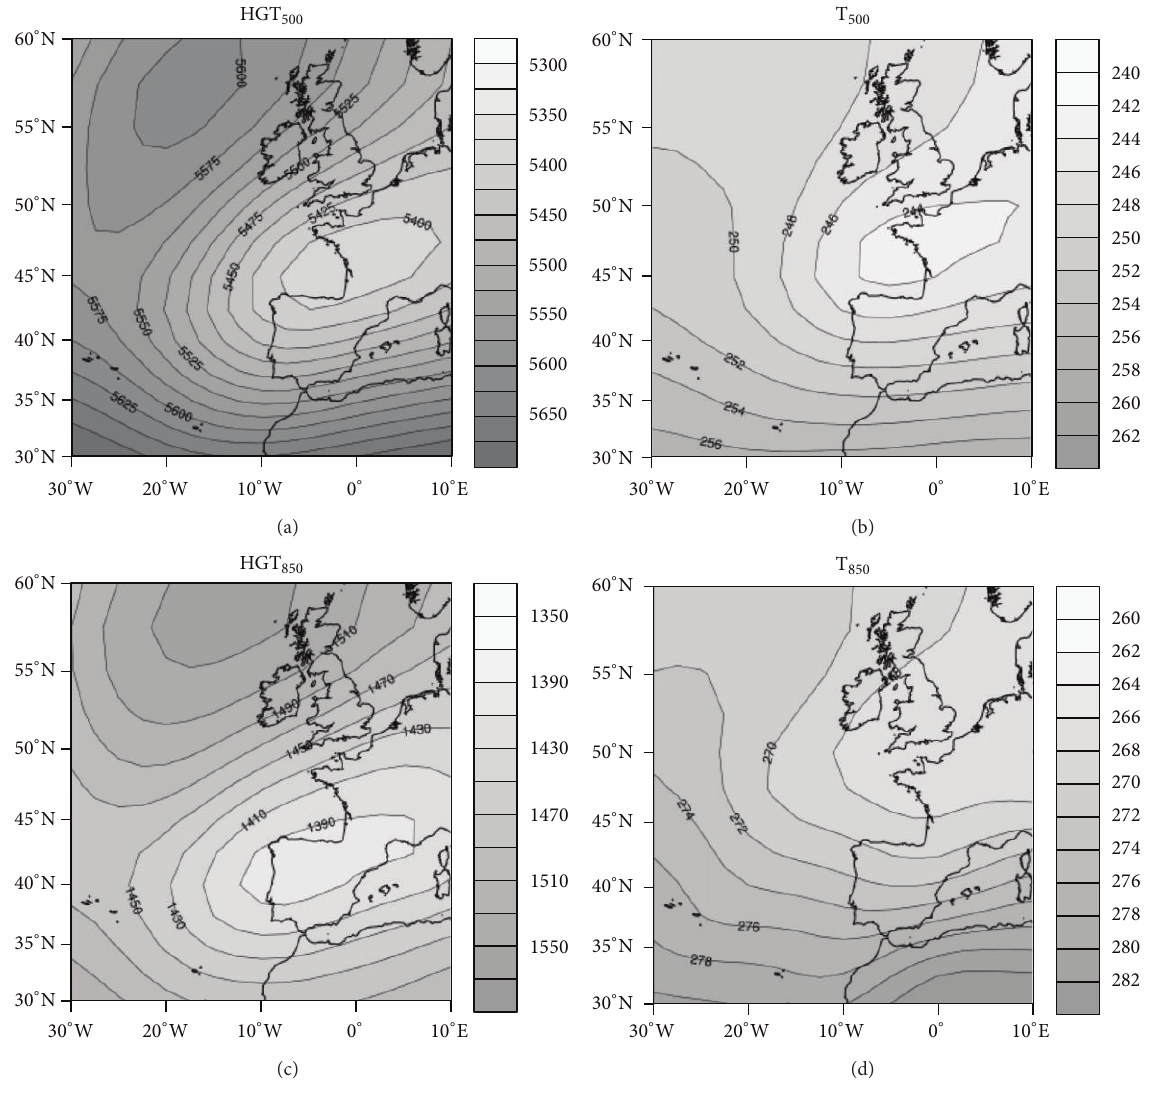
Figure 8: As in Figure 2 but for cluster